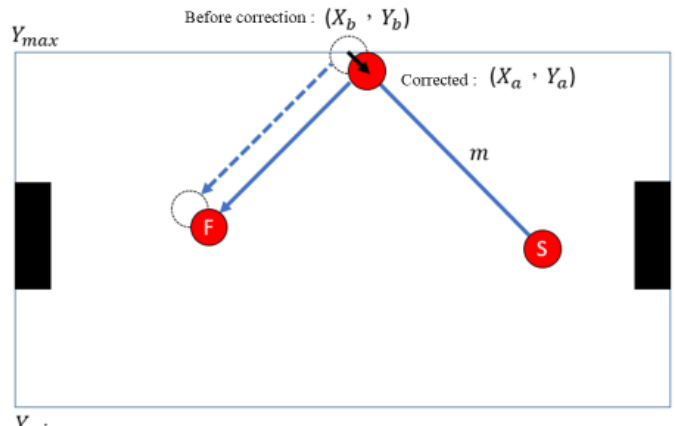
Figure 7. Schematic diagram of linear formula combined with the law of reflection.